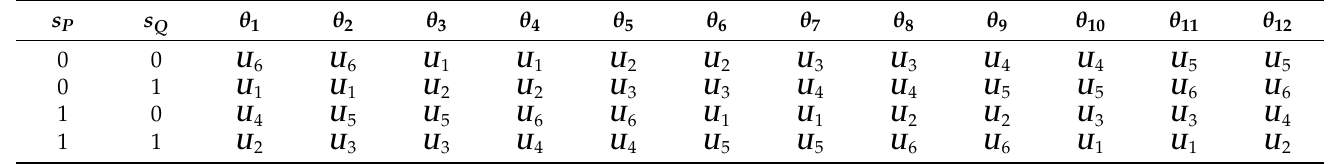
Table 3. Switching table based on the traditional 12-sector division.